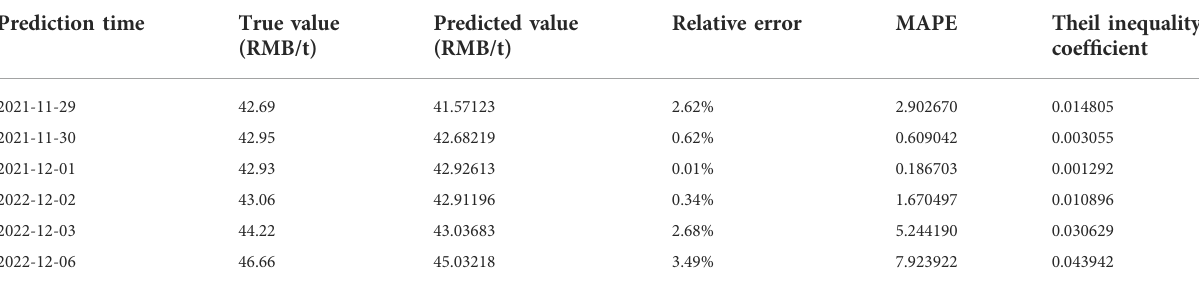
TABLE 6 Forecasting of CEA bene fi t